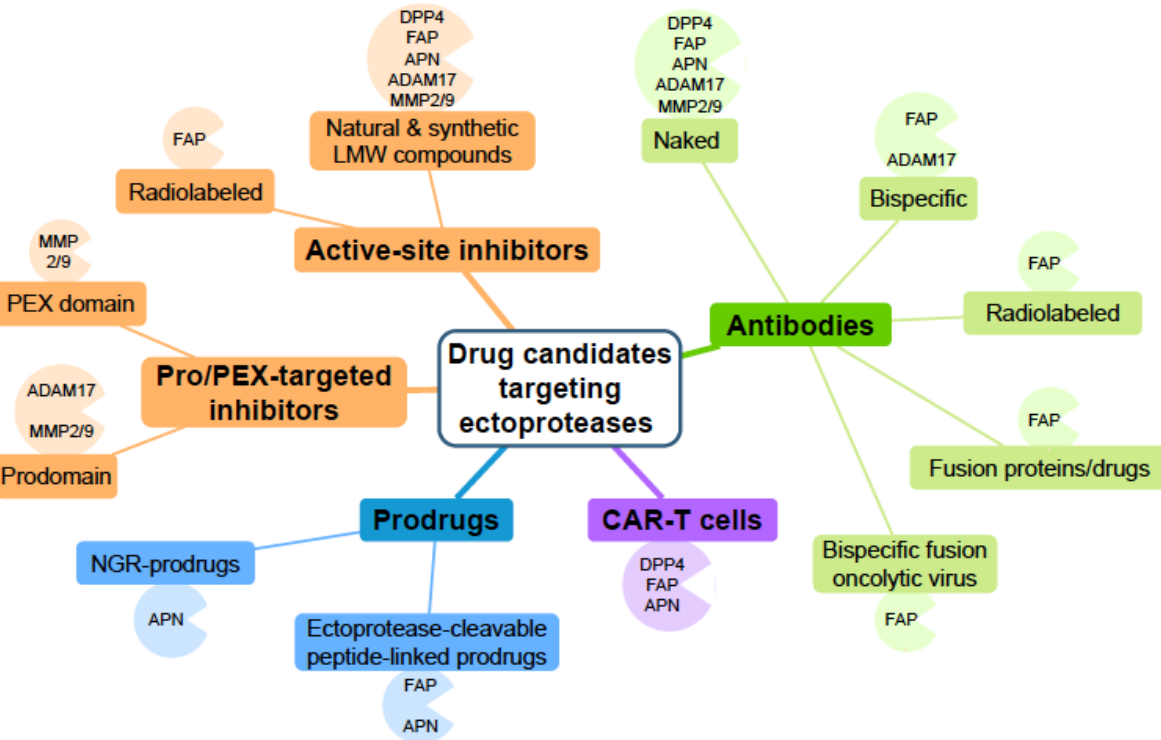
Figure 3. Schematic diagram summarizing the panel of drug candidates targeting cancer-associated ectoproteases in the context of cancer therapy. ectoproteases in the context of cancer